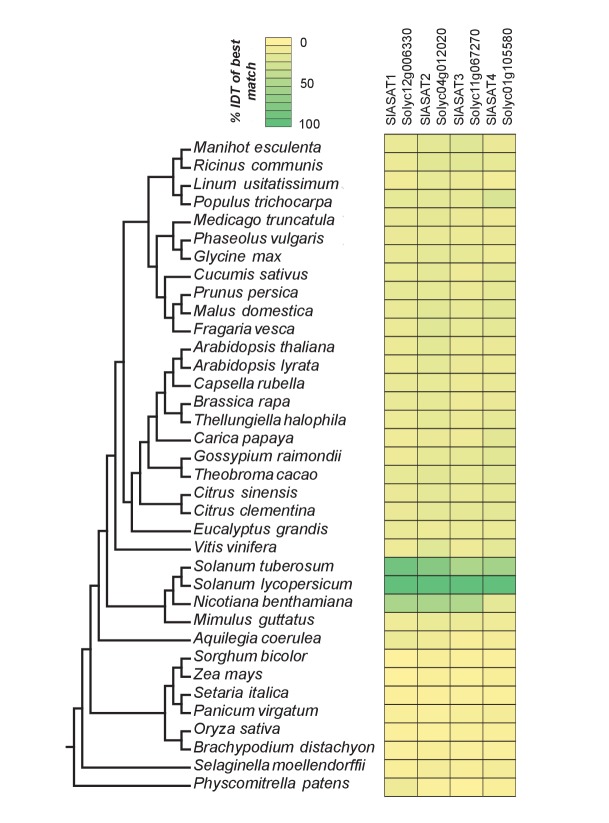
The phylogenetic context of tomato ASATs.Results of protein BLAST (BLASTP) between SlASAT sequences and proteomes of each species in the Phytozome database. The % identity (% IDT) values for the top BLASTP hits in each species are shown.